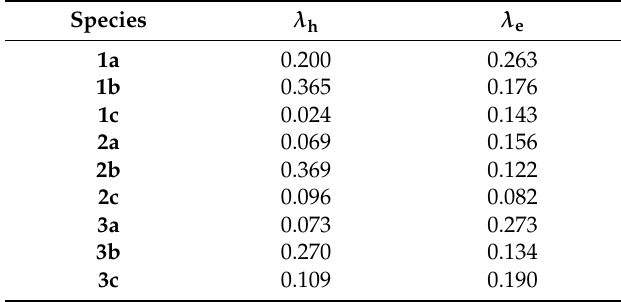
Table 4. The predicted λ e and λ h (both in eV) of the designed molecules at the B3LYP/6-31G(d,p) level. Species λ h λ e 1a